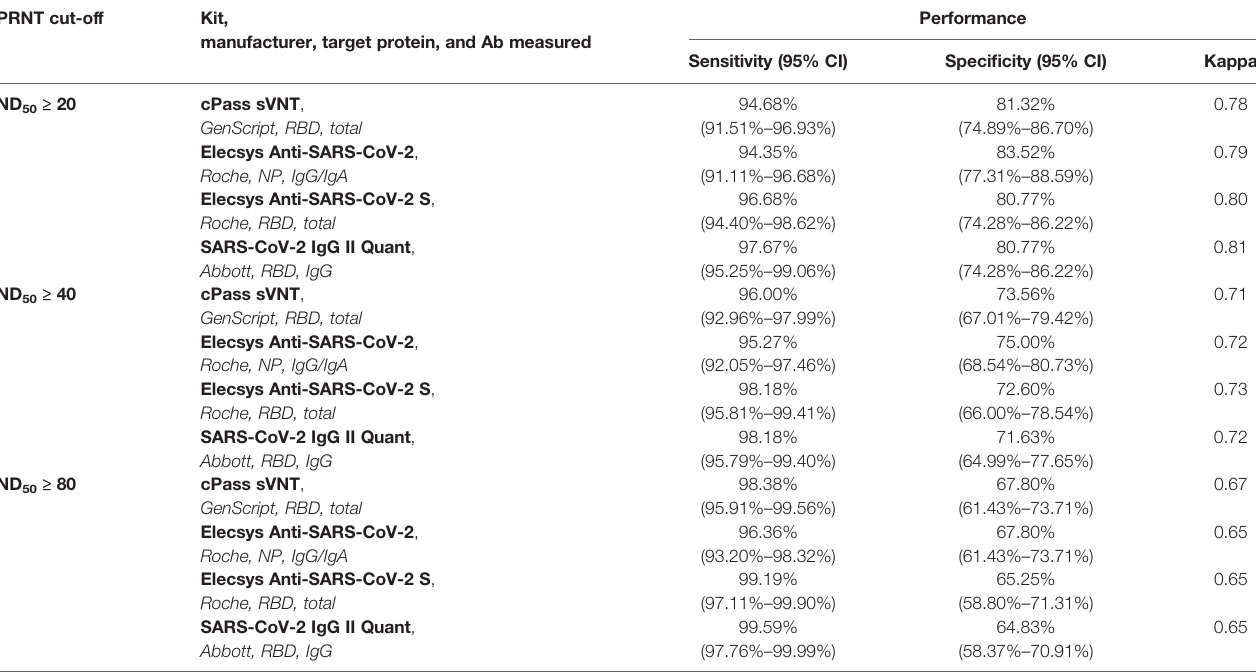
TABLE 3 | Analytical performance for representativeness of neutralizing activity using the pre-de fi ned cut-off values of each immunoassay kit. PRNT cut-off Kit, manufacturer, target protein, and Ab